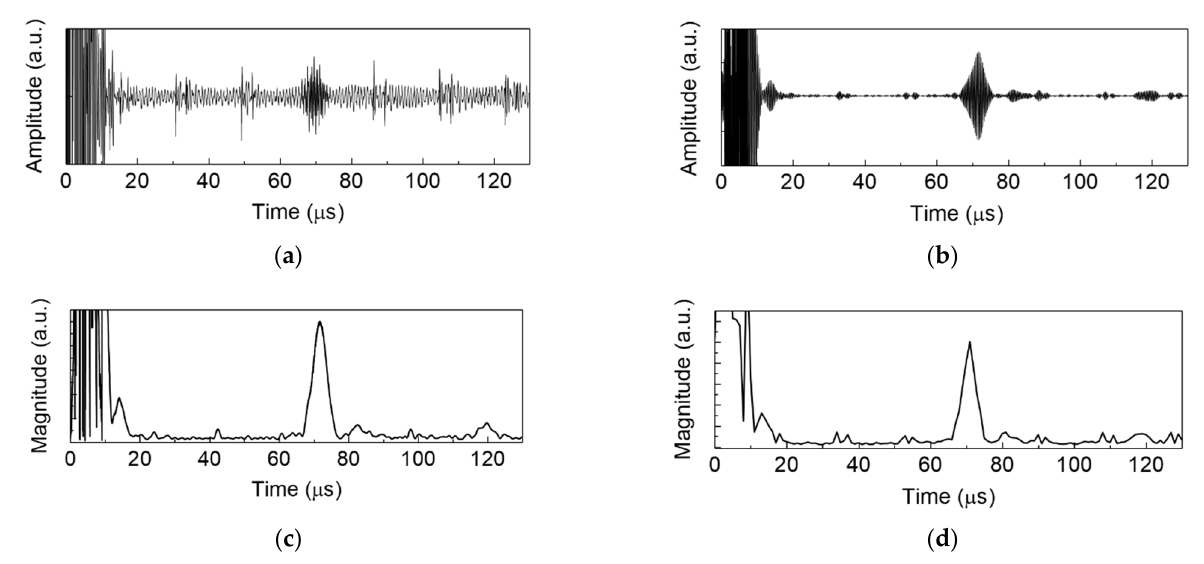
Figure 7. As an example, experimental results for the 8th DWT element operation in the active ultrasonic SHM edge system: ( a ) raw ultrasonic signal; ( b ) band passed filtered signals; ( c ) rectified and enveloped ultrasonic signal; and ( d ) decimated ultrasonic signal.